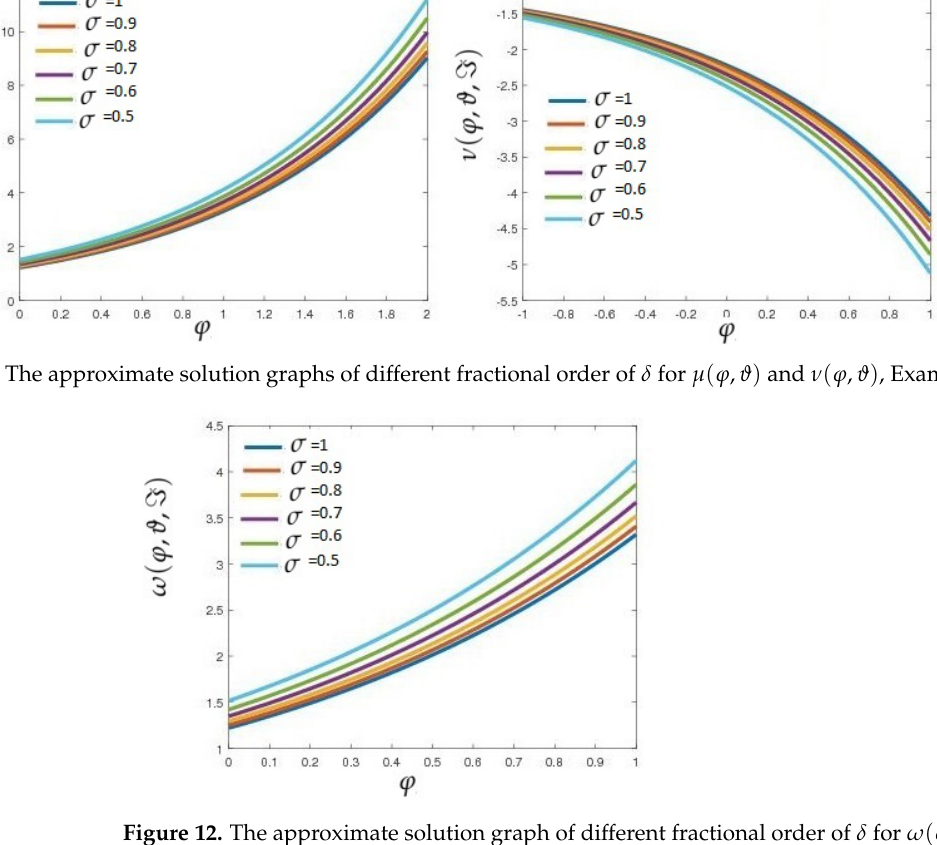
Figure 12. The approximate solution graph of different fractional order of δ for ω ( ϕ , ϑ )